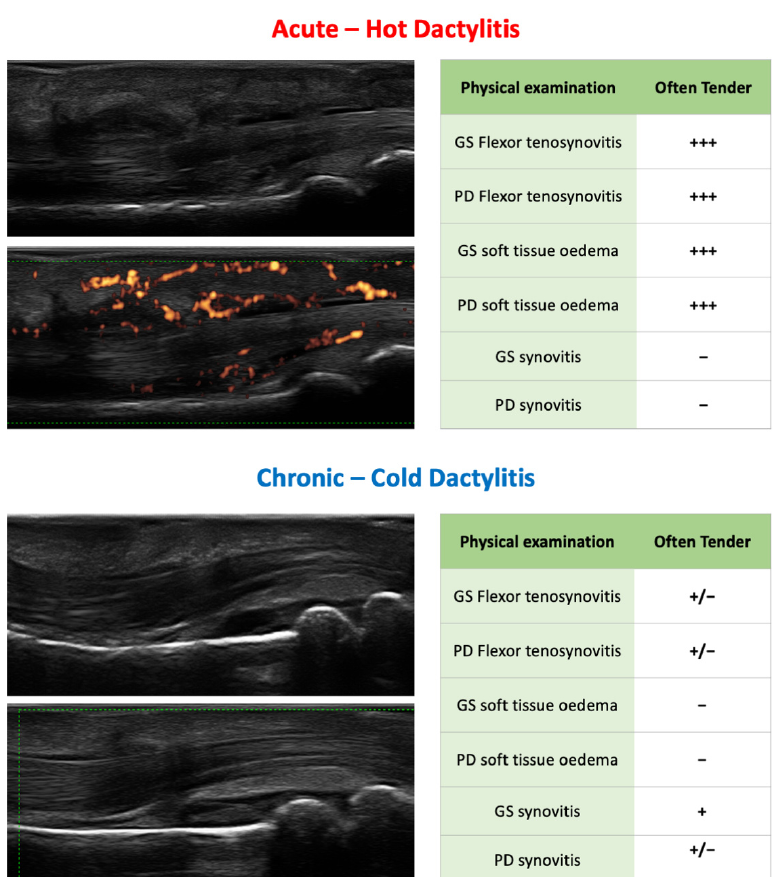
Figure 2. This figure summarizes the clinical and ultrasound characteristics of acute/hot and chronic/cold forms of dactylitis: Flexor tenosynovitis and soft tissue oedema are predominant in